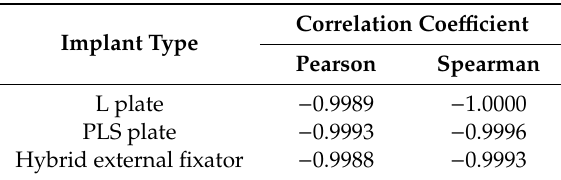
Table 2. Pearson and Spearman correlation coe ffi